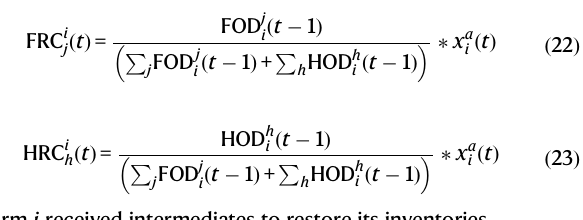
Table 7 for a sensitivity analysis for different allocation